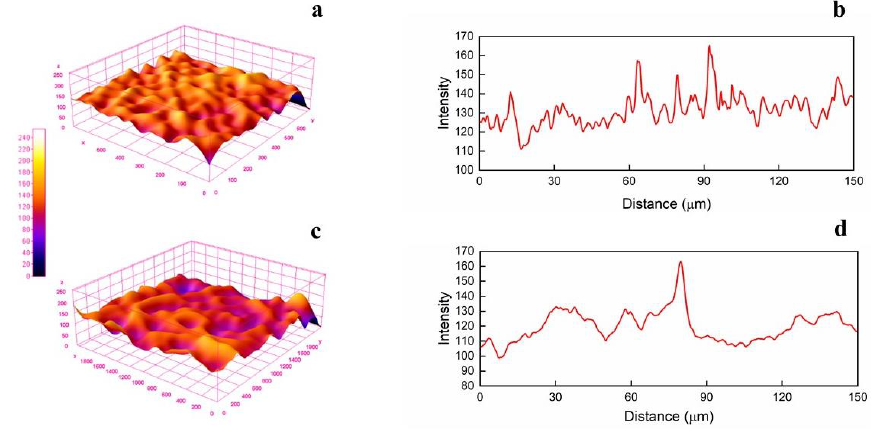
Figure 2. Three-dimensional surface plots of electrospun systems ((a): PCL/PVP and (c): Querc- PCL/PVP) and profile plots ((b): PCL/PVP and (d):